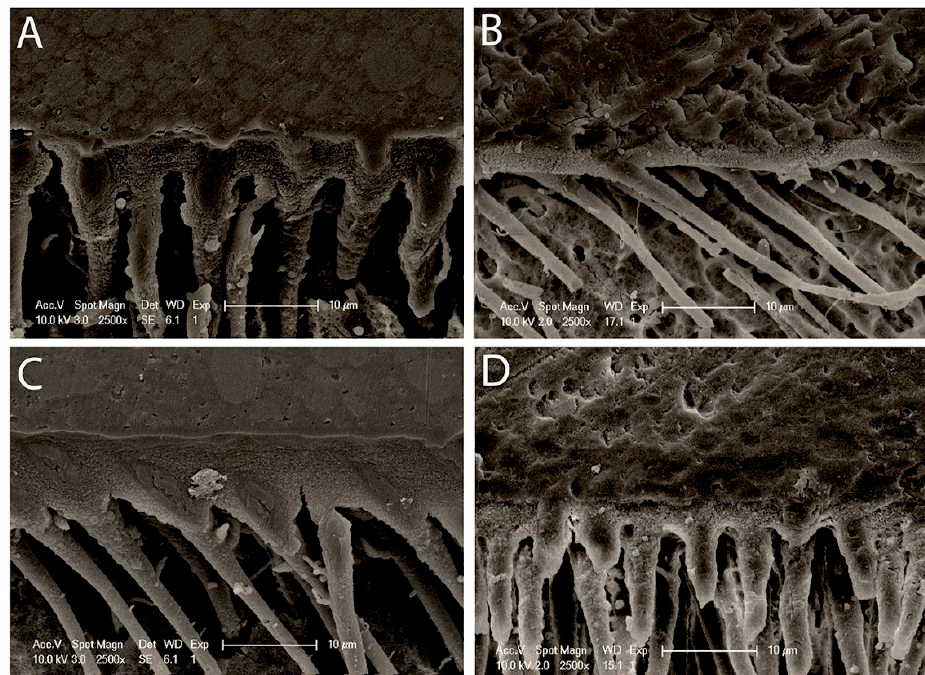
Figure 1. Representative SEM micrographs of the resin–dentin interface is shown from different bio-modification procedures. ( A ) Well-formed hybrid layer within the resin–dentin interface produced by Prime&Bond active TM applied on self-etch mode and a regular cylindrical shape exhibiting a rough texture on top of the resin tags; ( B ) The 0.5% RB-modified adhesive specimens showed a thinner hybrid layer; ( C ) Relatively thicker and textured hybrid layer with long well-formed resin tags could be seen with the 1% RB-modified adhesive specimens; ( D ) Well-defined uniform hybrid layer and with well-formed branched resin tags could be observed with 2% RB-modified adhesive. HL: hybrid layer, RT: resin tags.